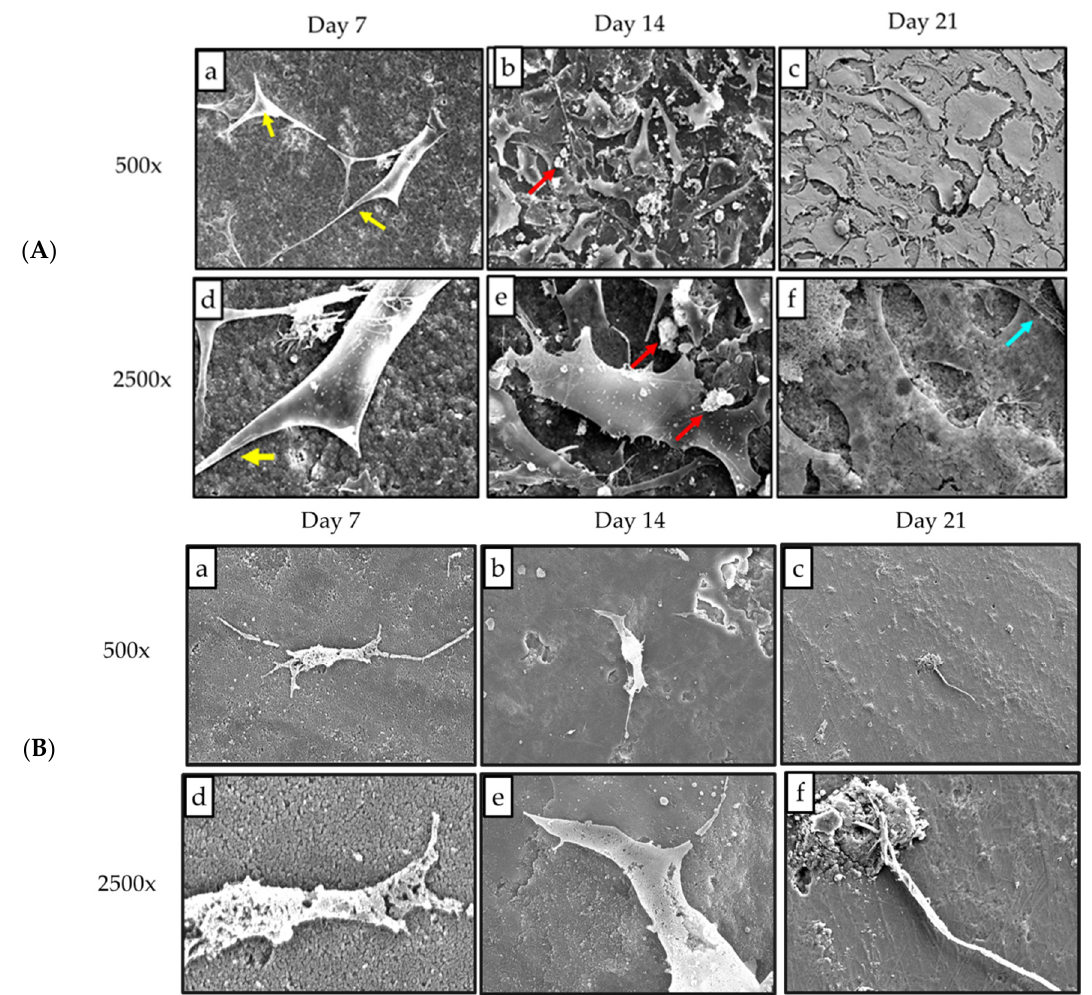
Figure 3. ( A ) FESEM micrographs of MC3T3-E1 preosteoblast cells seeded on the sinter hydroxyapatite sca ff old. The presence of cytoplasmic extension (yellow arrow), hydroxyapatite nodules (red arrow), and fiber strands (blue arrow) were observed in both low (500 × ) and high magnification (2500 × ); ( B ) FESEM micrographs of MC3T3-E1 preosteoblast cells seeded on the nonsinter hydroxyapatite sca ff olds. At higher magnification (2500 × ), cells exhibit destruction of cell morphology with absence of apatite nodules.